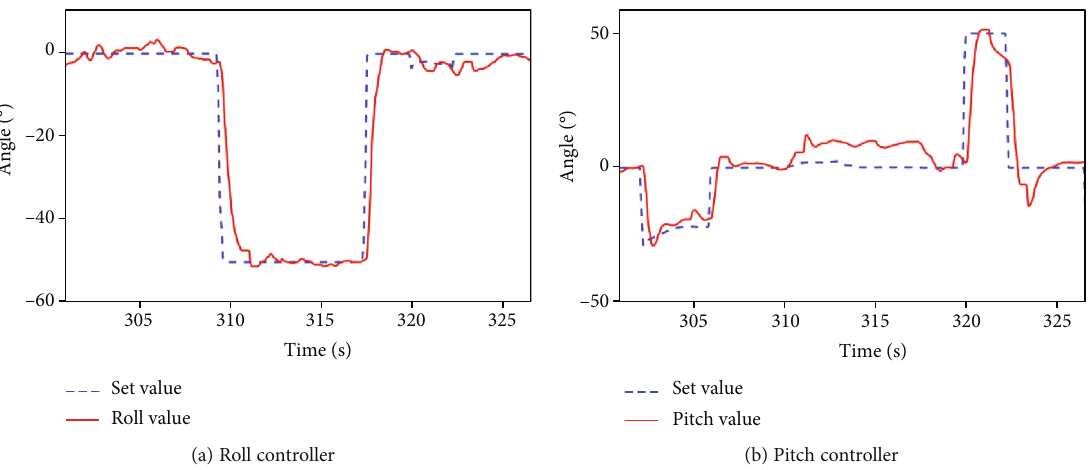
Figure 9: Behaviour of the roll and pitch controllers. During this time, the roll angle from (a) shows no de fl ection angle. In (b), the pilot changes the set value from 0 ° to -25 ° . The pitch controller is reacting to this command and reaches the commanded angle. While the airframe is fl ying, a left fl ight turns the pitch angle positive, which means that the pitch controller and the decoupling system are too strong. At 320 seconds, the airframe gets a command to fl y upwards; the roll angle shows no de fl ection from this